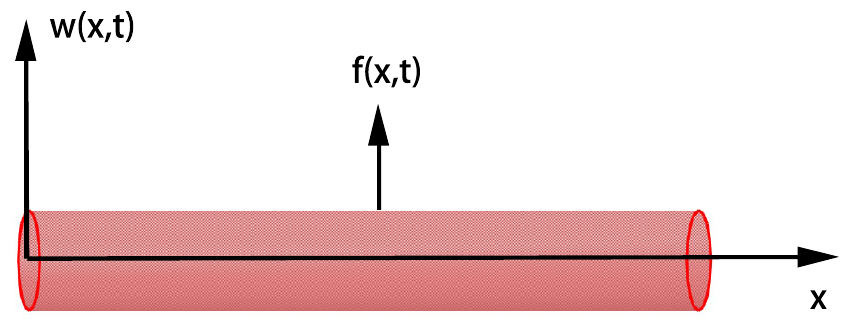
Figure 1. The geometric shape of viscoelastic